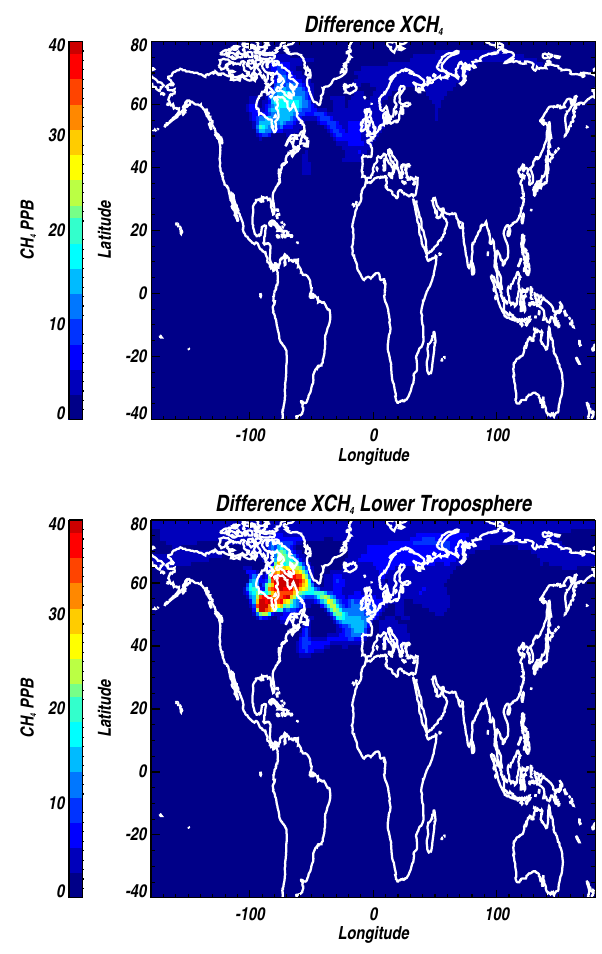
Figure 4. Top: difference in XCH 4 between a reference GEOS- Chem run and another in which the Hudson Bay lowland flux (48 to 66 ◦ N and 100 to 70 ◦ W) has been reduced by half. Bottom: same as in top panel but for the lower